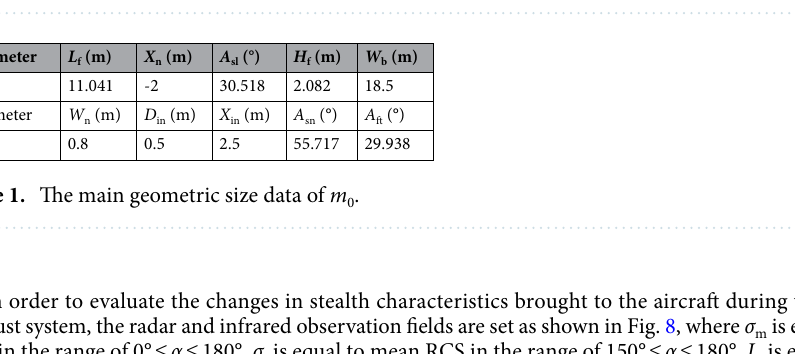
Figure 6. Three-view display of aircraft geometric model, drawn using Microsoft Visio 2007 and CATIA V5R20.